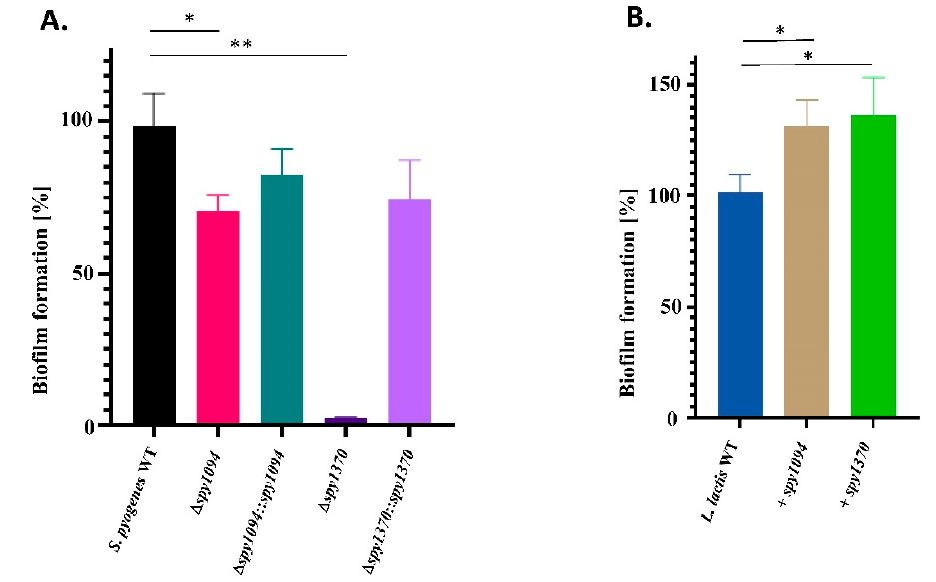
Figure 5. Spy1094 and Spy1370 contribute to biofilm formation. Wildtype and mutant strains were grown on uncoated 96 ‐ well plates and incubated at 37 °C overnight. Biofilms were measured in triplicates after addition of crystal violet dye by measuring absorbance at 595 nm. ( A ) S. pyogenes wildtype and mutants. ( B ) L. lactis wild ‐ type and mutants. Data are mean values from four inde ‐ pendent experiments in triplicates +/ − SD. P values were calculated using the one ‐ way ANOVA tests. ** p < 0.001; * p < 0.05. ** p < 0.001; * p <